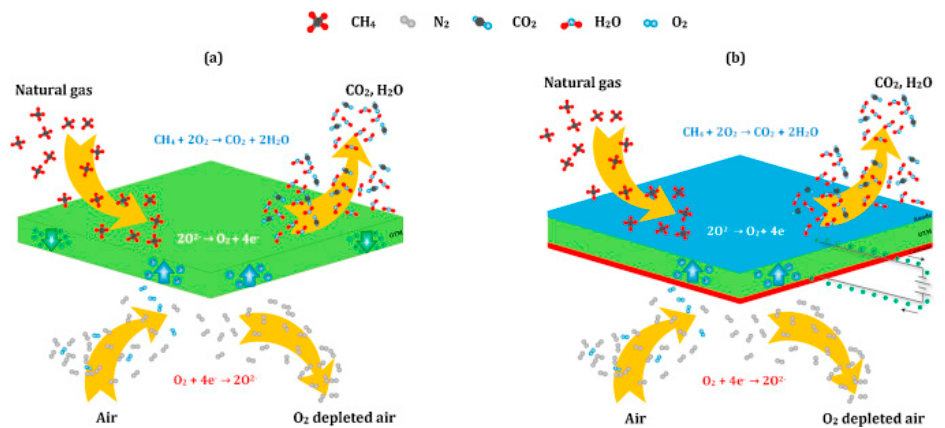
Figure 3. Comparative schematic of: ( a ) a mixed ionic-electronic conductor (MIEC) and ( b ) an ionic conductor, both used as oxygen transport membranes, adapted from [17], with permission from Elsevier, 2018.